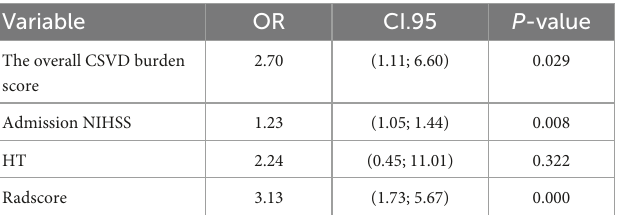
TABLE 4 The nomogram model of multivariate regression results.